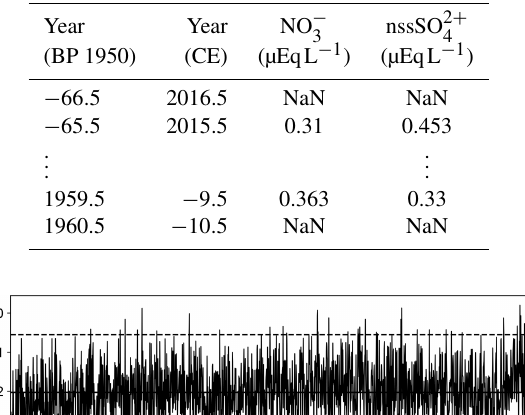
Table 7. Summer-centred annual data columns included in “DSS_2k_summer_centred.csv” file.